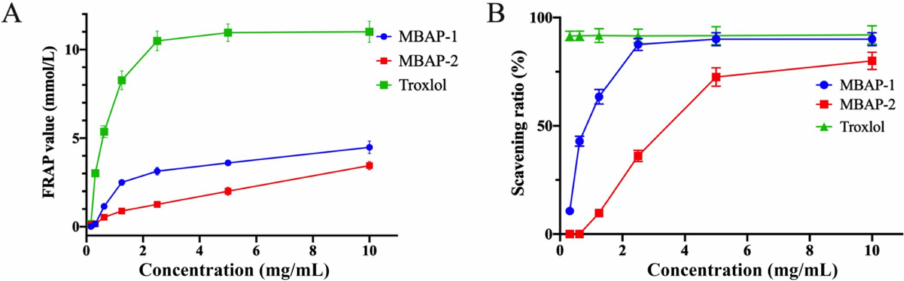
Figure 8. Antioxidant activities of MBAP-1 and MBAP-2. ( A ) The FRAP results of MBAP-1 and MBAP-2. ( B ) The ABTS results of MBAP-1 and